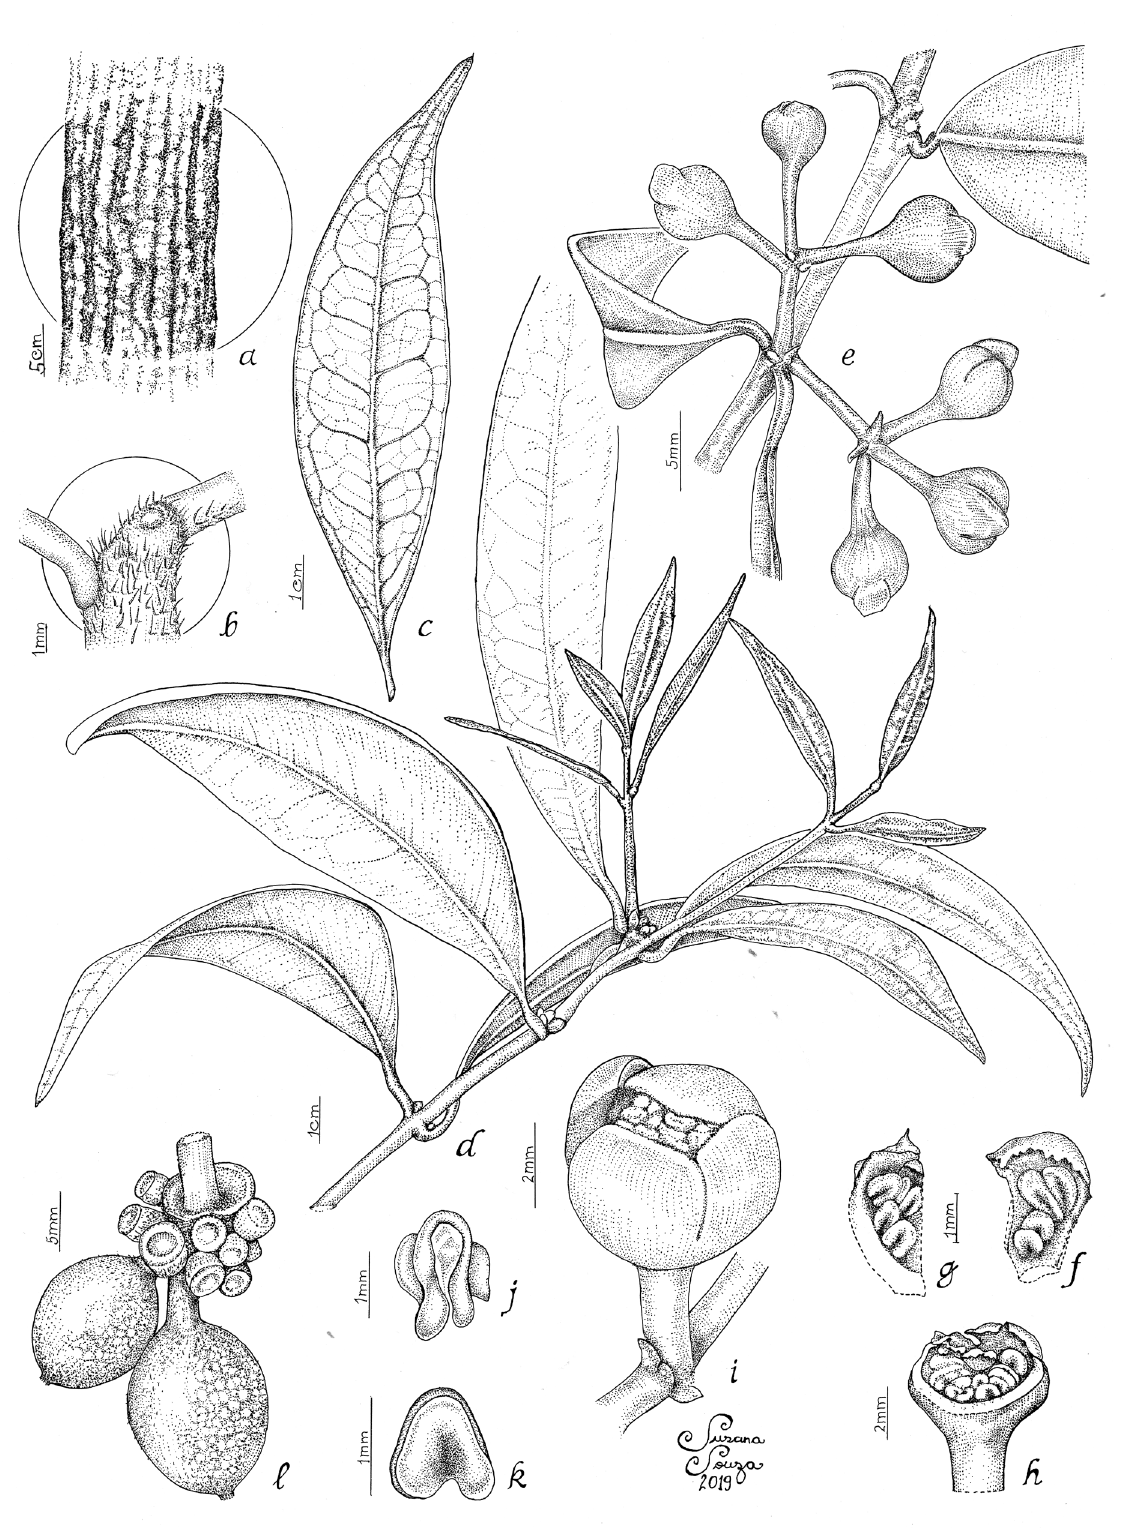
Figure 1 – Mollinedia ruschii . A . Trunk. B . Branch detail showing trichomes. C . Leaf showing venation. D . Branch. E . Staminate inflorescence. F . Dissected staminate flower showing internal tepal. G . Dissected staminate flower showing external tepal. H . Staminate flower receptacle showing stamens. I . Staminate flower in detail. J . Dehiscent stamens. K . Stamens in frontal view. L . Fruiting receptacle with drupelets. A, C, D, E, & I from E.J. Lírio & M.R. Neto 1548 (MBML); B from L.D. Thomaz 1656 (RB); F, G, H, J, & K from E.J. Lírio & V.L. Aledi 20 (RB); and L from L.J. Kollmann 2302 (RB). Drawing by Susana